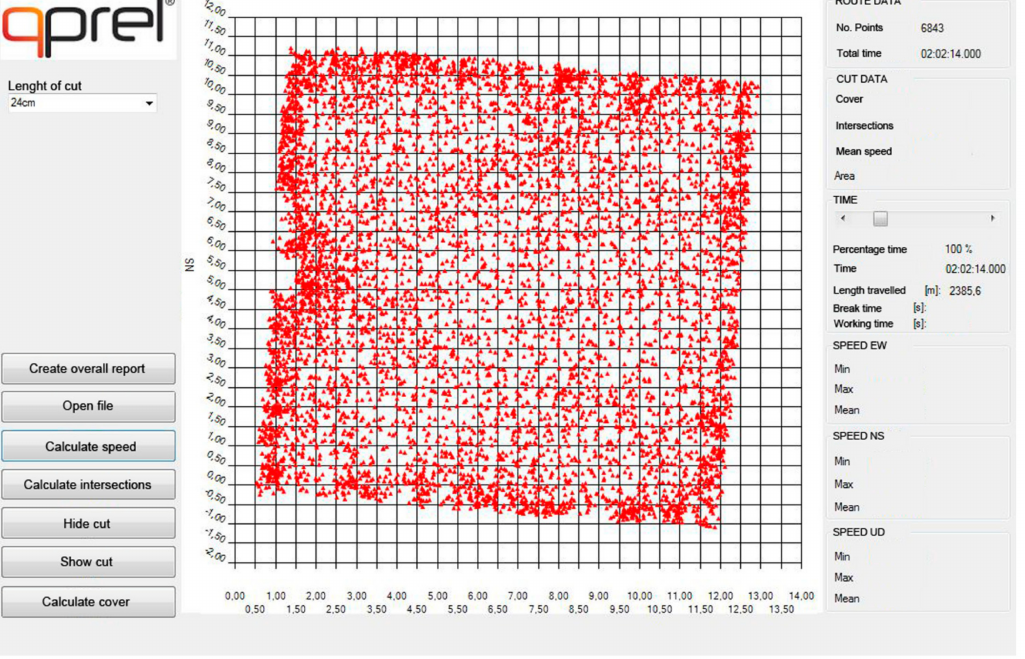
Figure 3. Window of the “Robot mower tracking data calculator” software showing the robot mower coordinates (red triangles) within a square turfgrass area shape for the total cutting time (two hours and two